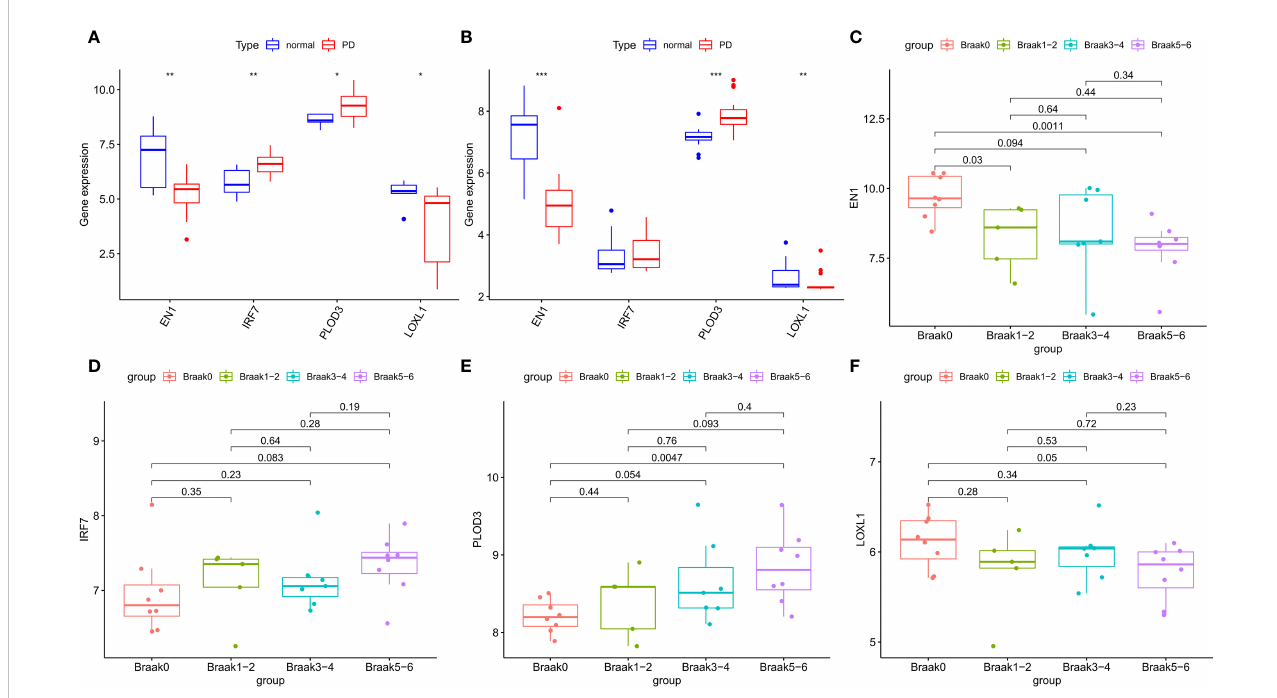
FIGURE 6 Expression validation of characteristic NFRGs. (A) Characterization of NRGs expression in the internal validation cohort (GSE7621). (B) Characterization of NRGs expression in the external validation cohort (GSE20163). (C – F) Expression of characteristic NRGs in different stages of PD